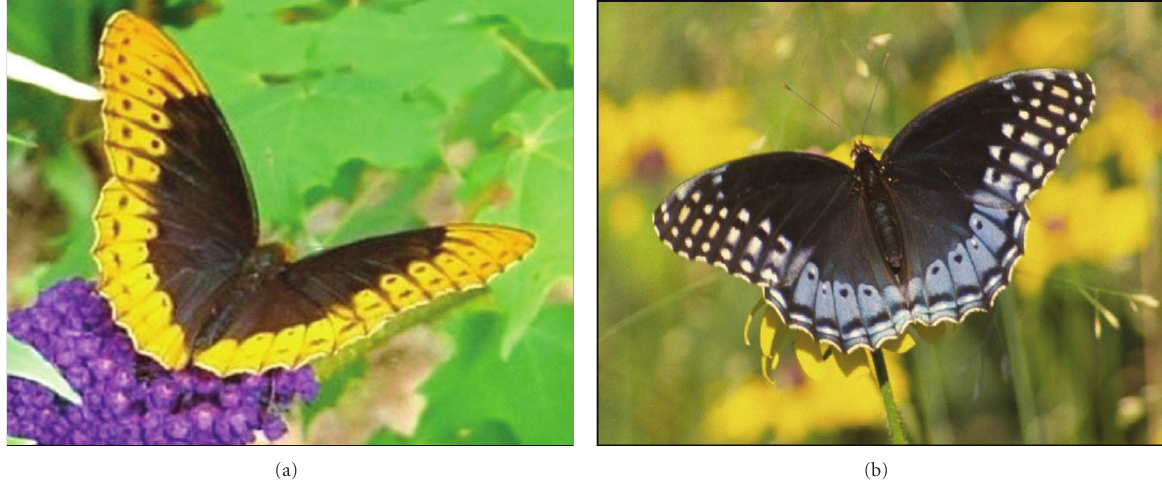
Figure 1: Argynnis diana male (top, orange and black) and female (bottom, blue and black) adults are sexually dimorphic and striking with their bright coloration. Photos by Connie Wells